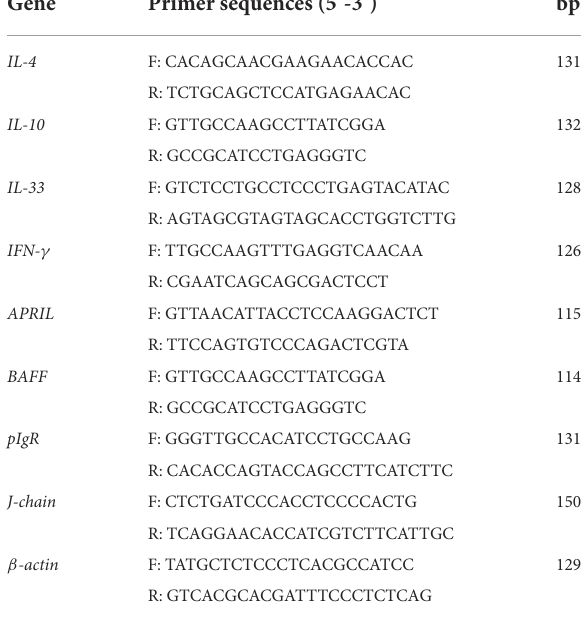
TABLE 1 Sequences of primers for